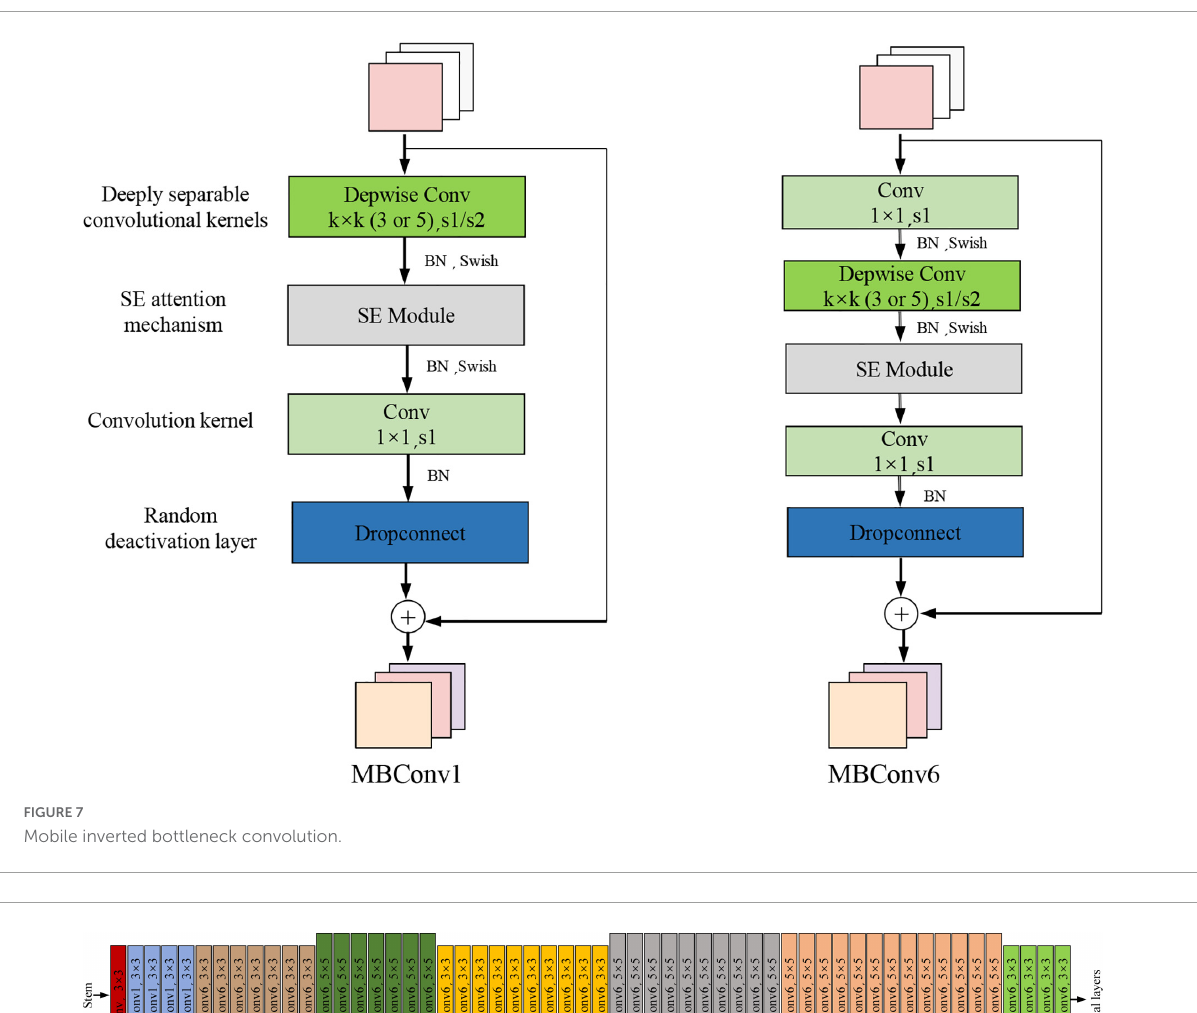
FIGURE8 The network structure of EfficientNet-B7.